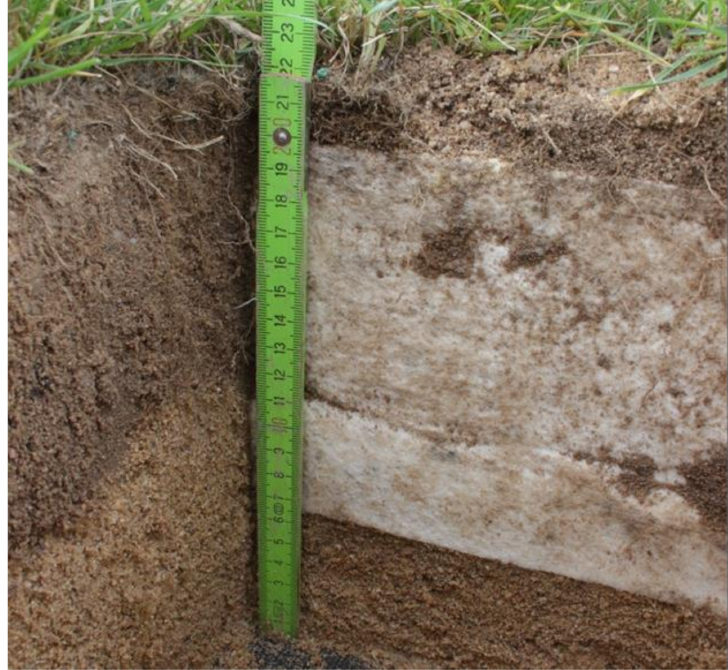
Figure 3. The vertically incorporated biodegradable nonwoven in a